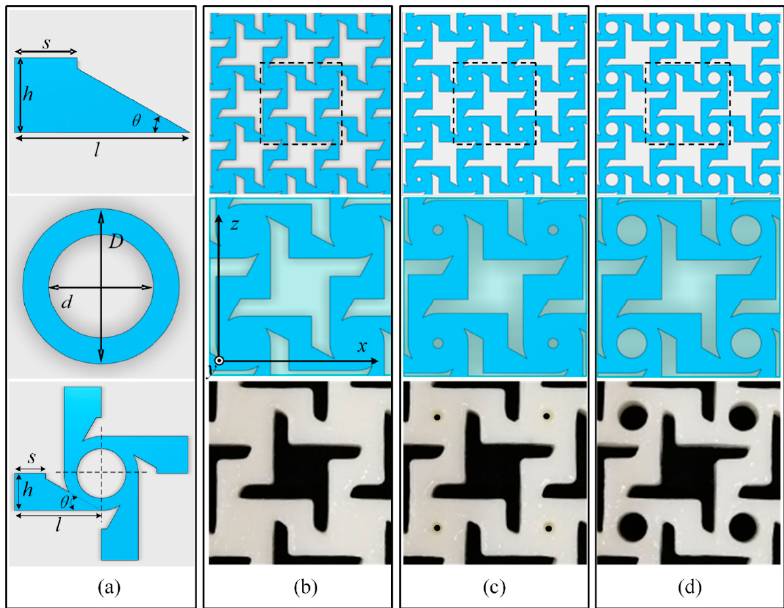
Figure 2. Dimensions and printing model of the unit cell: ( a ) basic shapes and sizes; ( b – d ) assembled and printed models with hollow circle diameters of d = ( b ) 0, ( c ) 1, and ( d ) 3 mm.